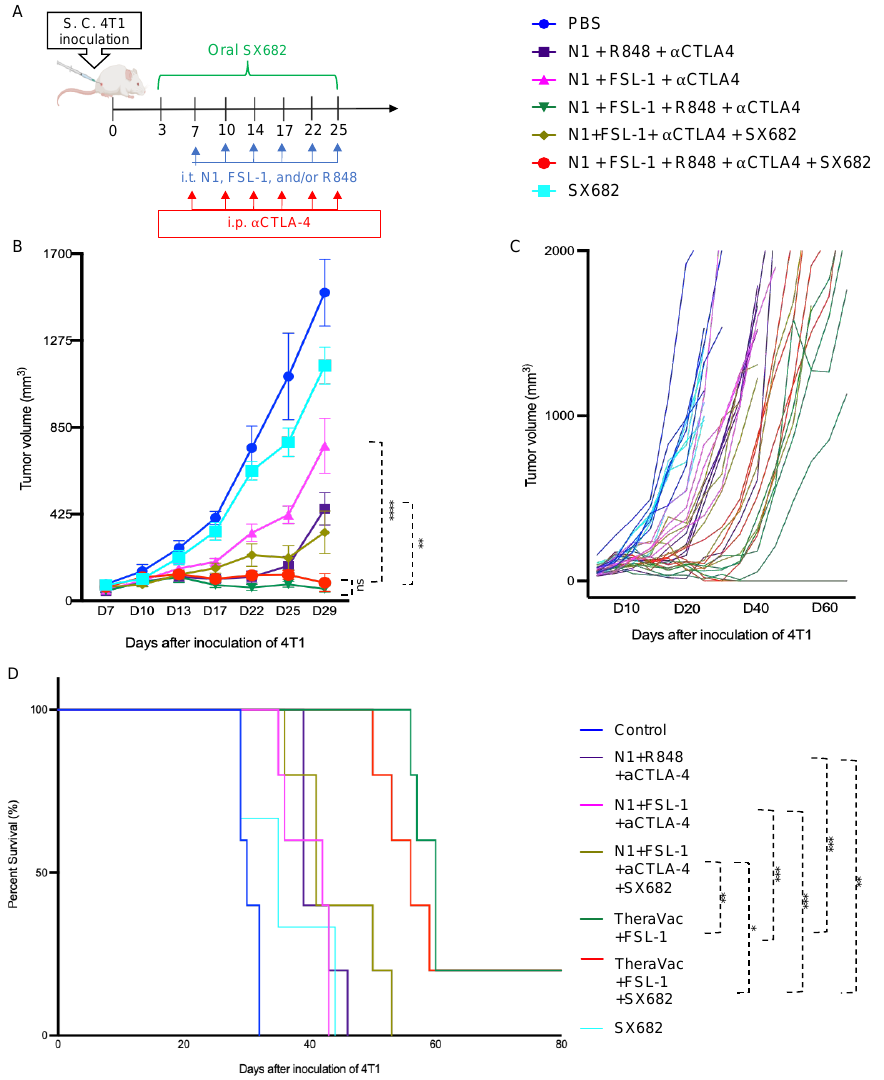
Figure 2. Antitumor effect of combination of HMGN1, FSL-1, and/or R848 with or without SX682 on mice bearing 4T1 breast carcinomas. ( A ) Scheme of 4T1 inoculation and treatment. ( B ) Effect on 4T1 tumor growth in mice (n = 5) being treated with Control/PBS (blue line), SX682 (aqua line), N1 + R848 + α CTLA-4 (purple line), N1 + FSL-1 + α CTLA-4 (pink line), N1 + FSL-1 + α CTLA-4 + SX682 (golden line), N1 + FSL-1 + α CTLA-4 + R848 (green line), N1 + FSL-1 + α CTLA-4 + R848 + SX682 (red line). Data are shown as mean ± SEM. ( C ) Effect of tumor growth in individual mouse of indicated groups. ( D ) The survival curves for each group are also indicated. * p < 0.05; ** p < 0.01; *** p < 0.001; and **** p < 0.0001.